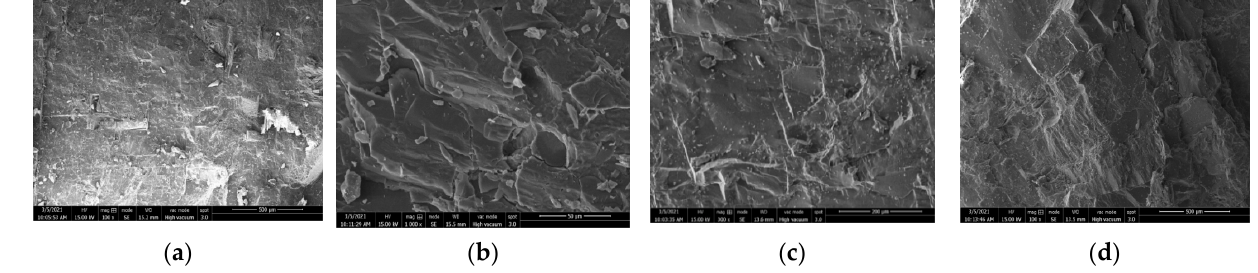
Figure 16. Typical microscopic morphology of oblique fracture fragments. ( a ) Step wiping and flower wiping; ( b ) Step wiping and flower wiping; ( c ) Parallel stripe pattern; ( d ) Transgranular pull flowers.